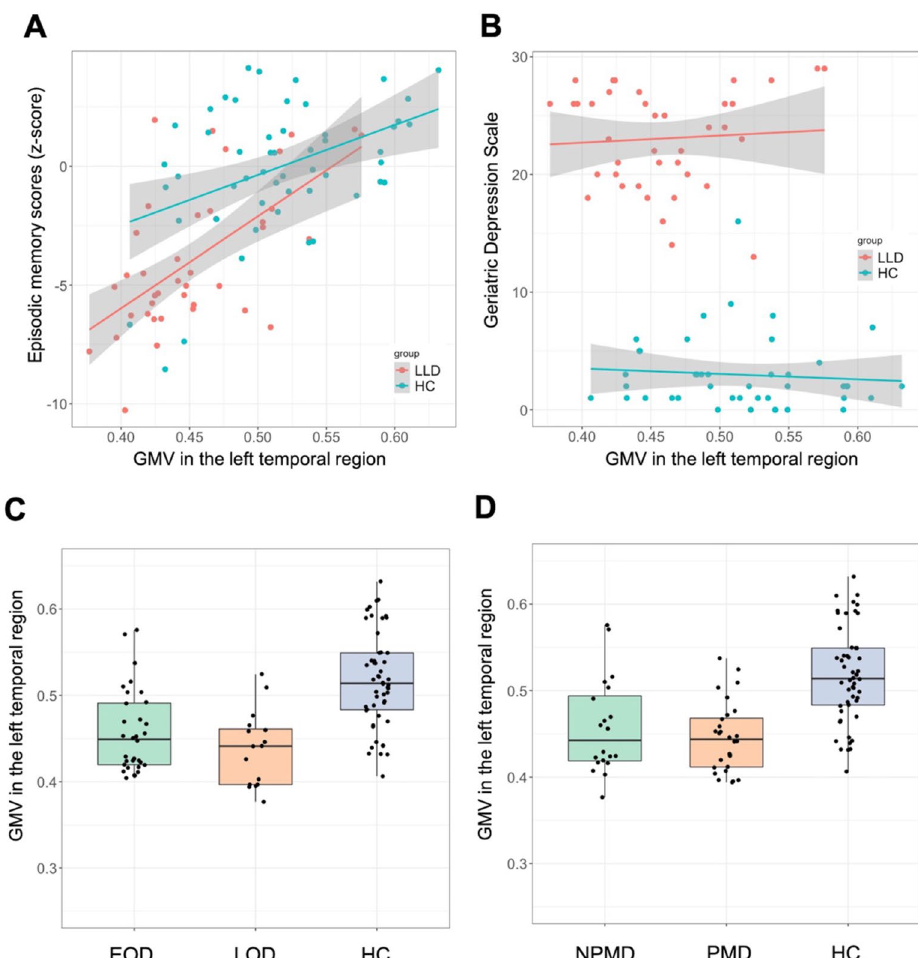
Figure 2. Associations of clinical factors with regional GMV decrease in the left temporal region. Episodic memory scores correlated with lower GMV in the left temporal region. To illustrate the results of the MANCOVAs, scatter plots of ( A ) episodic memory scores and ( B ) GDS, and boxplots of ( C ) onset age and ( D ) the presence of psychosis are presented. Episodic memory scores ( A ) had a significant main effect on regional GMV difference, whereas other clinical factors ( B – D ) did not have significant main effect. In all figures, data from healthy controls are also overlaid for reference. Y-axis in ( C , D ) represents mean voxel values in the left temporal cluster. EOD early-onset depression, GDS geriatric depression scale, GMV gray matter volume, HC healthy control, LLD late-life depression, LOD late-onset depression, NPMD non-psychotic major depression, PMD psychotic major